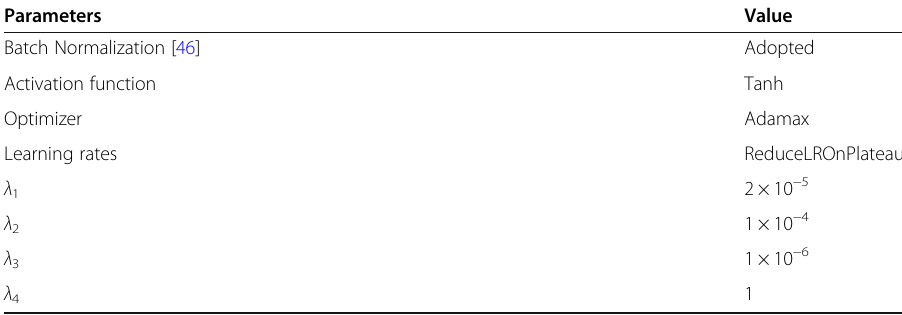
Table 5 The training parameters